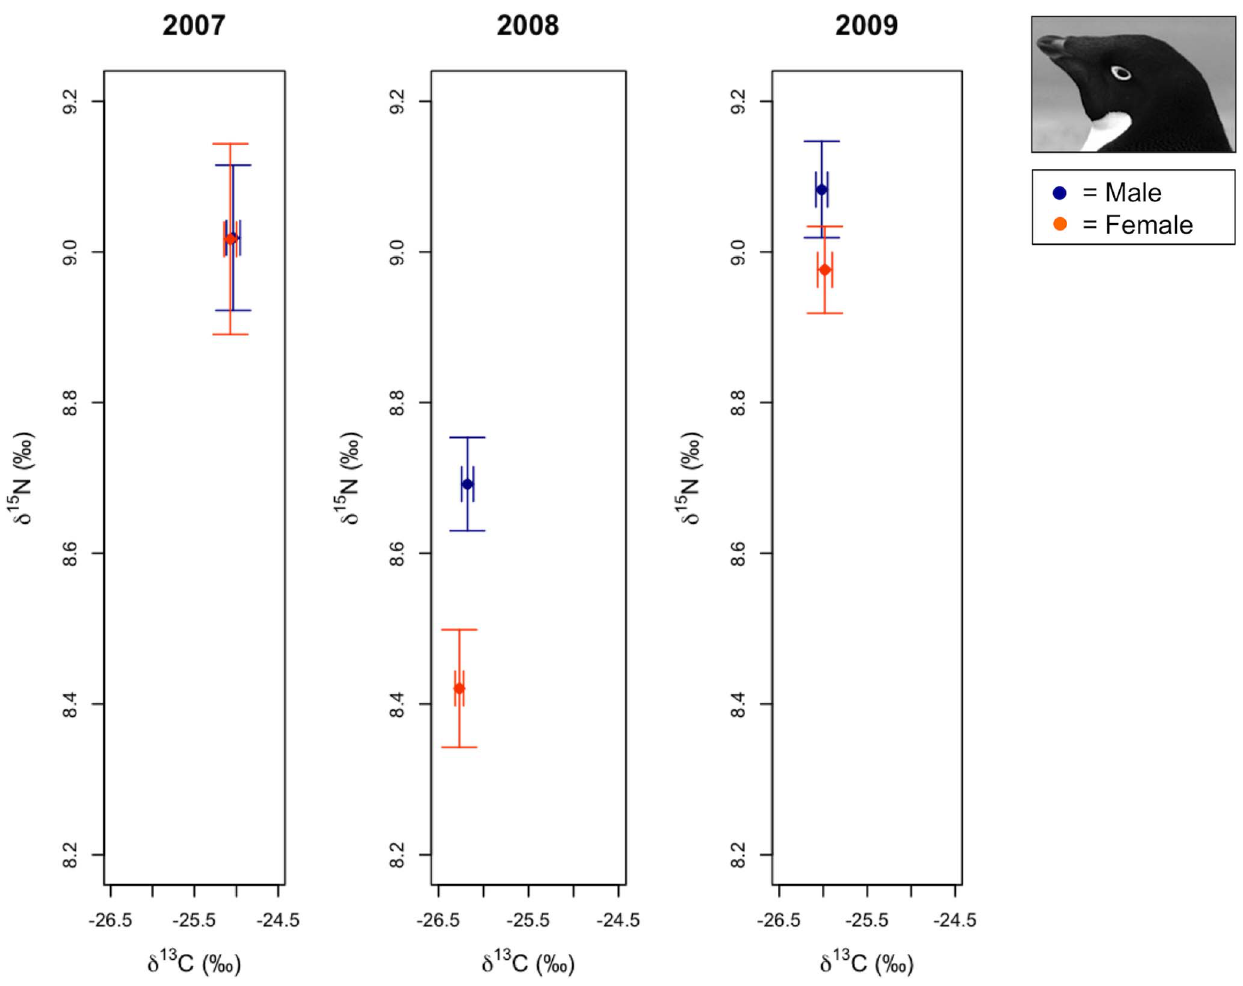
Figure 3. Variation in Ade´lie penguin d 13 C and d 15 N stable isotope signatures. Average male and female isotope signatures ( 6 1 SE) are presented for each year based on sample sizes exactly following analyses ( n =127 for d 13 C and n =128 for d 15